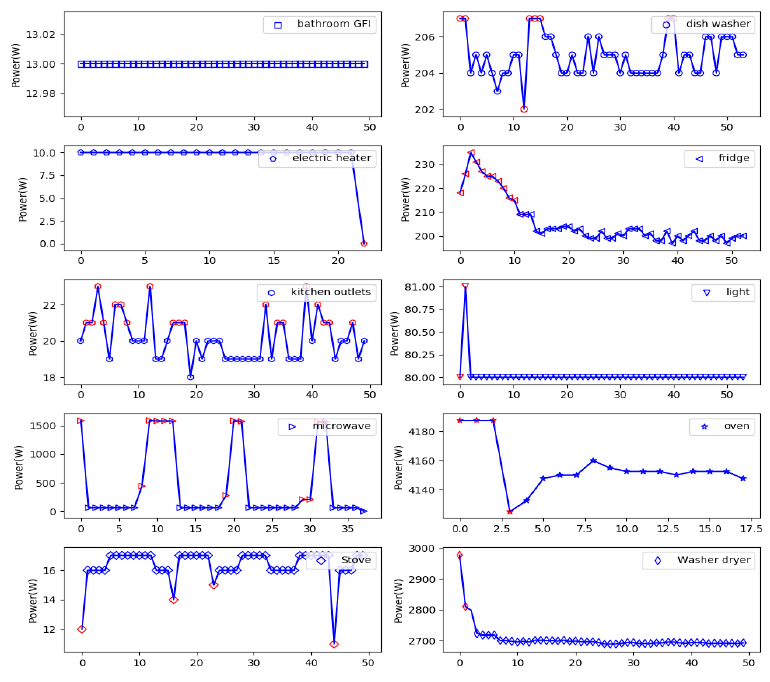
Figure 10. Identification result graphs.